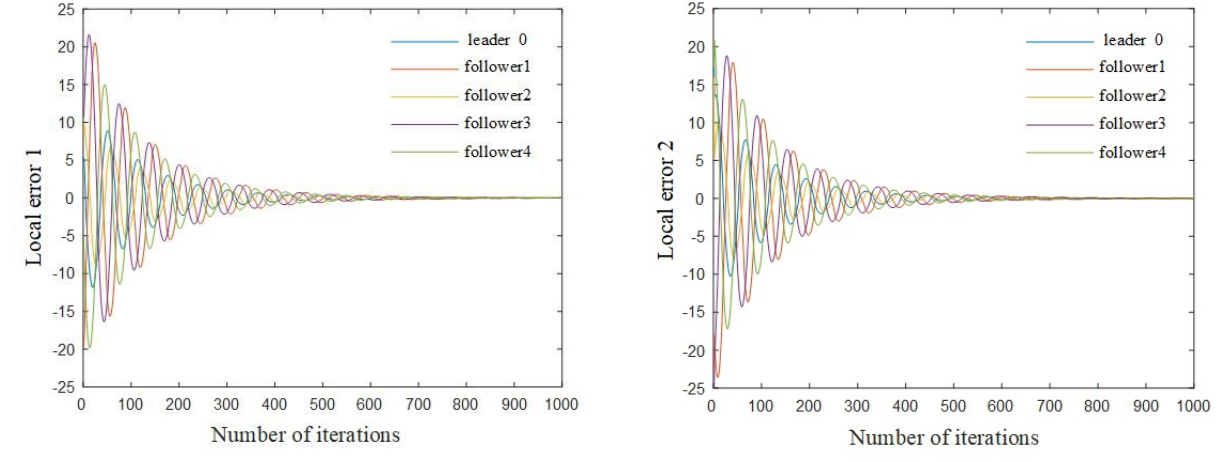
Fig. 2. The local error ε i 1 ( k ) in (2).